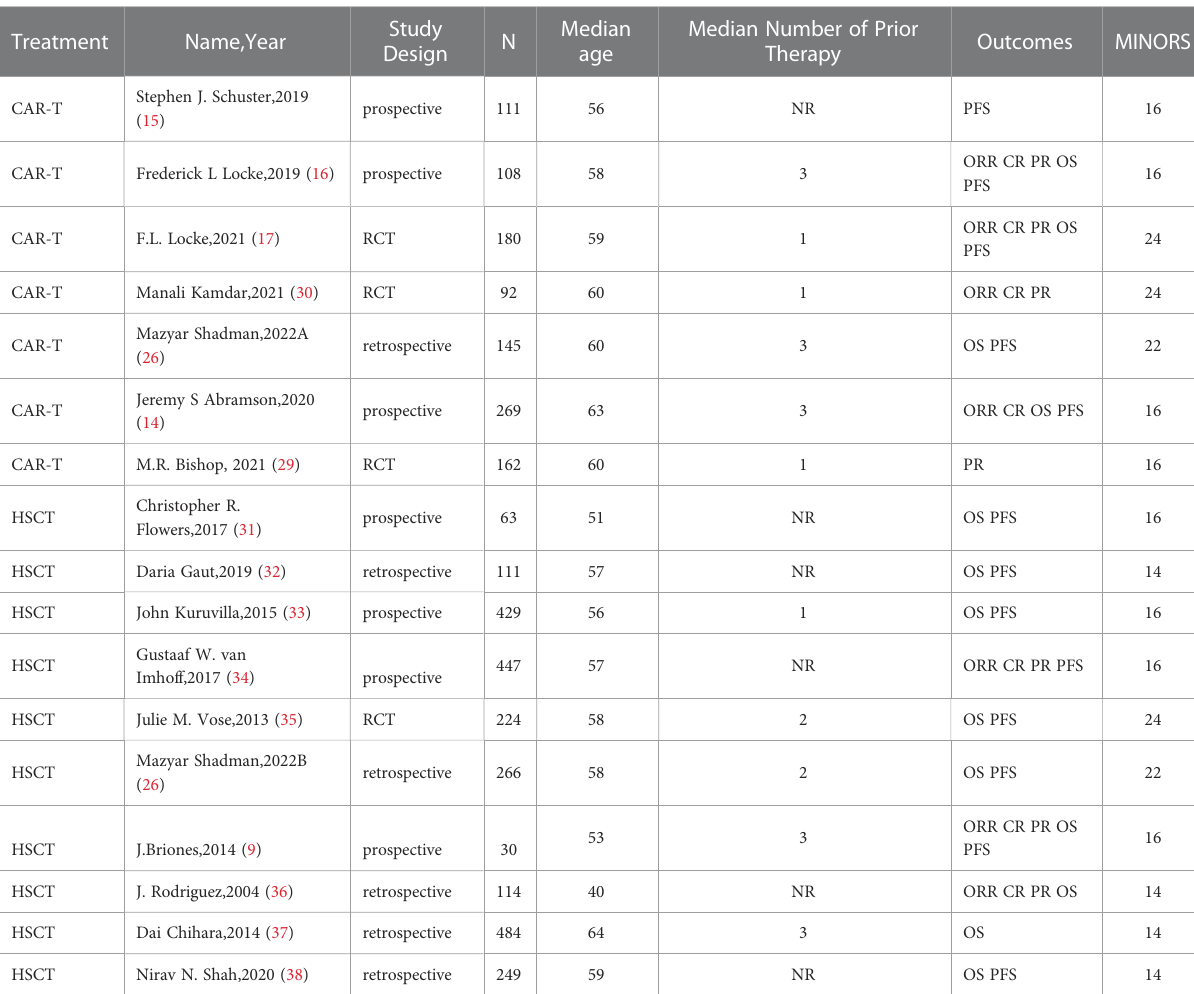
TABLE 1 Characteristics of included